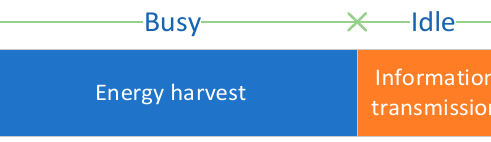
Figure 2. Harvest-then-transmit mode.